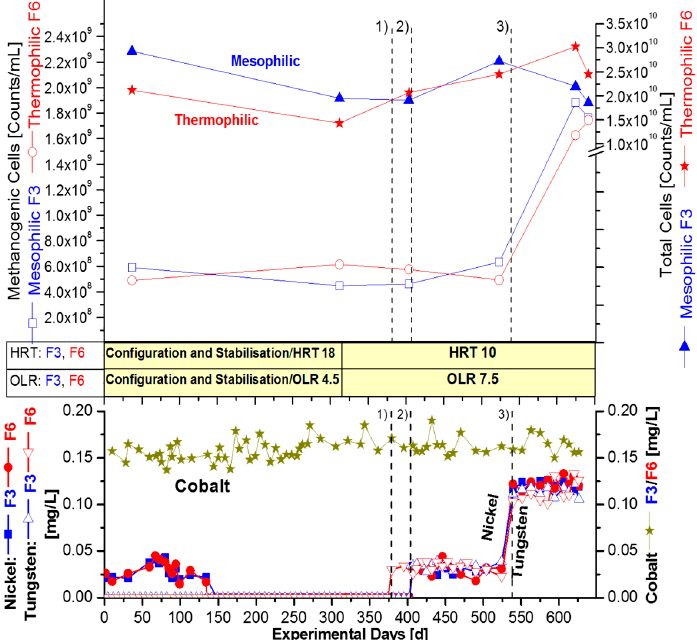
Figure 3. Combined addition of [nickel + tungsten] in fermenter F3 (mesophilic) and F6 (thermo- philic) over 640 days in 3 fermentation periods, with wheat straw as the sole substrate in ‘synthetic